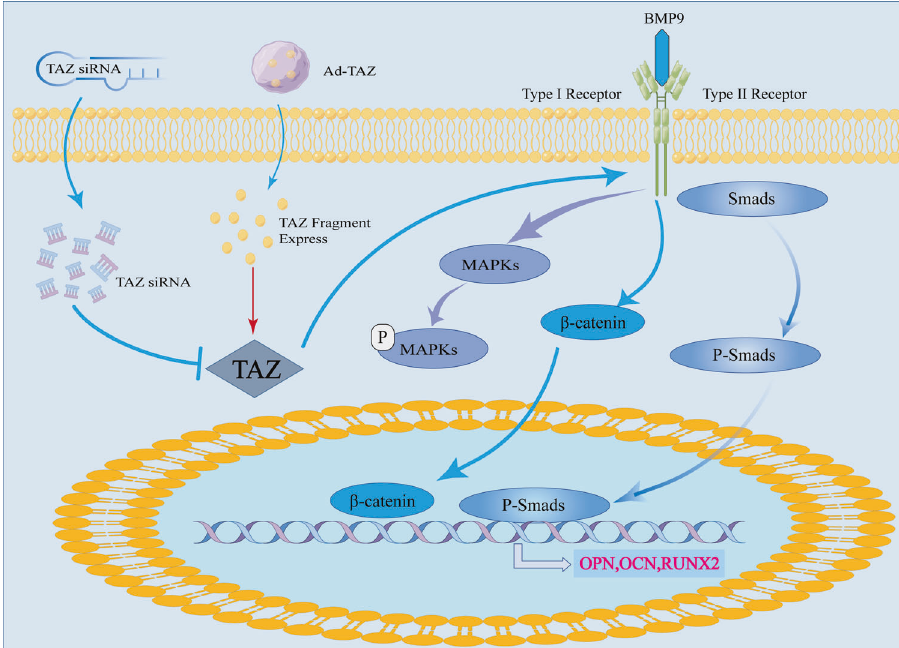
and promotes classical Smad1/5/8, Wnt/ β -catenin, and MAPKs signaling pathways induced by